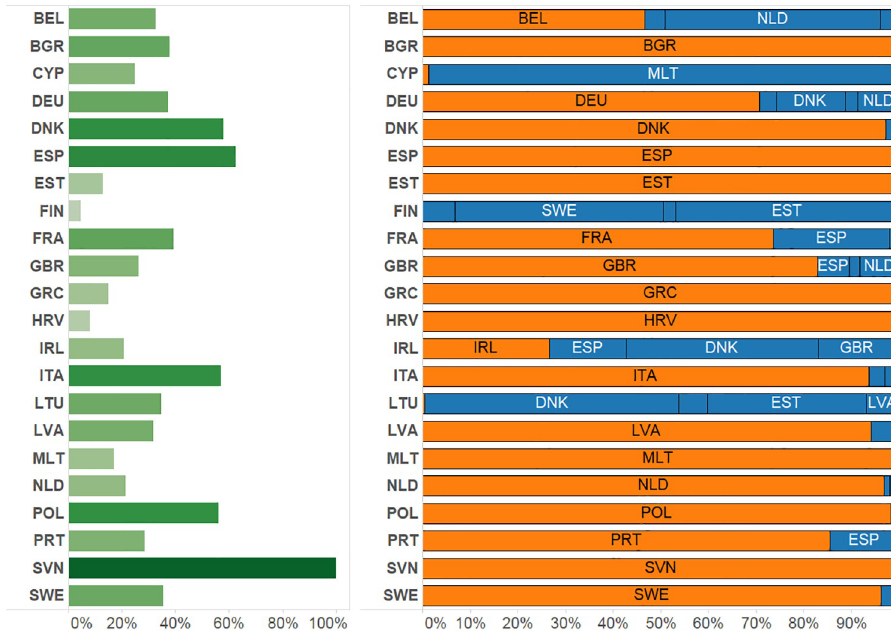
Fig 2. Gravity between ports. Left: percentage of vessels in each country for which the declared port in the fleet register coincides with the centre of gravity determined based on the number of AIS messages. Right: share of messages in ports of country of registration and ports of other countries. BEL: Belgium; BGR: Bulgaria; CYP: Cyprus; DEU: Germany; DNK: Denmark; ESP: Spain; EST: Estonia; FIN: Finland; FRA: France; GBR: UK; GRC: Greece; HRV: Croatia; IRL: Ireland; ITA: Italy; LTU: Lithuania; LVA: Latvia; MLT: Malta; NLD: Netherlands; POL: Poland; PRT: Portugal; SVN: Slovenia; SWE: Sweden.